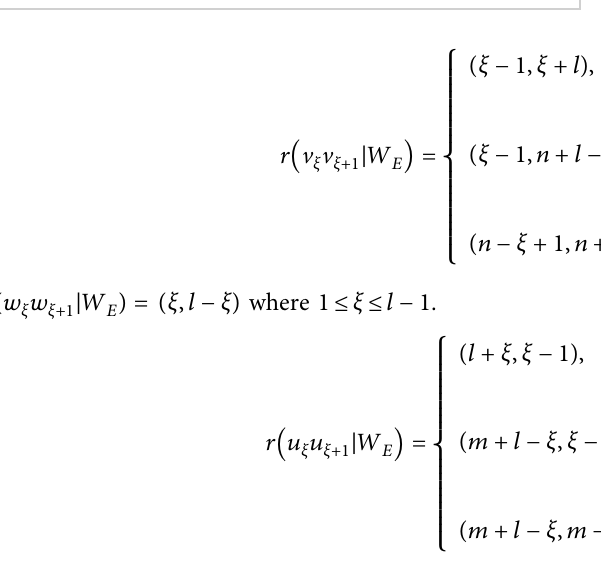
w l } . Figure 2 shows the graph The metric dimension of G l theorem.